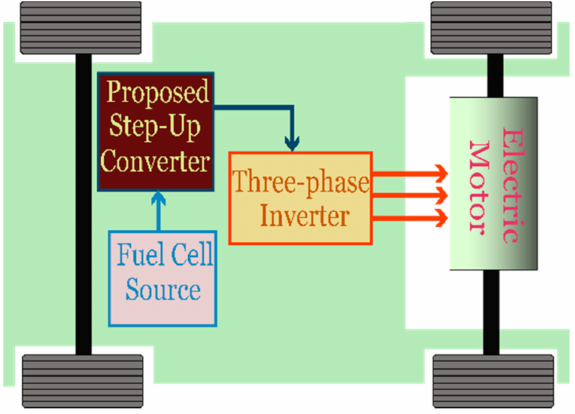
Figure 1. A fuel cell-powered electric vehicle (EV) with the proposed